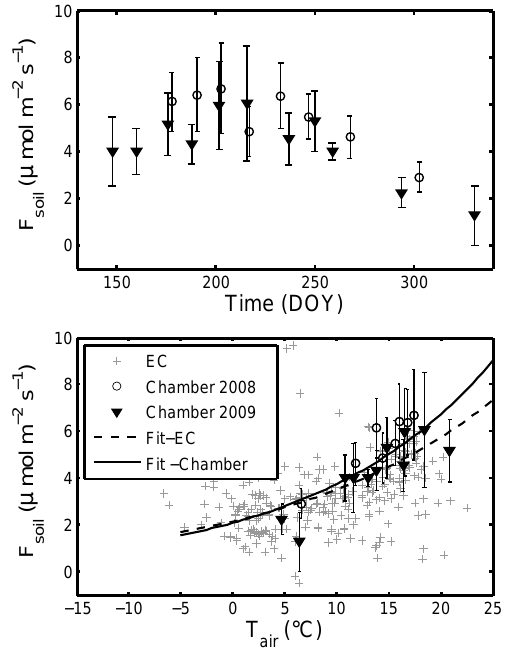
Fig. 10. (a) Soil chamber respiration ( F soil ) as a function of time, and (b) the dependence of F soil on daily air temperature ( T air ) in 2008 and 2009 (circles and triangles, respectively). In (b) the fit F soil = 2 . 1 ± 0 . 8 e ( 0 . 06 ± 0 . 03 T air ) (RMSE = 0.9µmolm − 2 s − 1 , R 2 = 0 . 65) is shown with a black line and the nocturnal fluxes (PAR < 5µmolm − 2 s − 1 ) measured with the EC technique from wind direction 200–240° are shown with grey crosses and fit F EC = ( 2 . 1 ± 1 . 7 )e ( 0 . 05 ± 0 . 05 T air ) (RMSE = 1.0µmolm − 2 s − 1 , R 2 = 0 . 32) with a black dashed